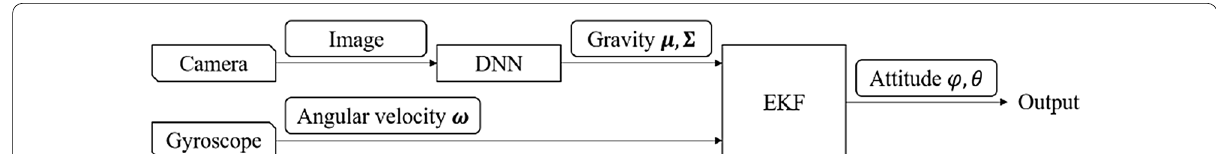
Fig. 10 Proposed EKF architecture. Gyroscopic angular rates are integrated in the prediction process in the EKF. The DNN outputs are integrated in the update process in the EKF